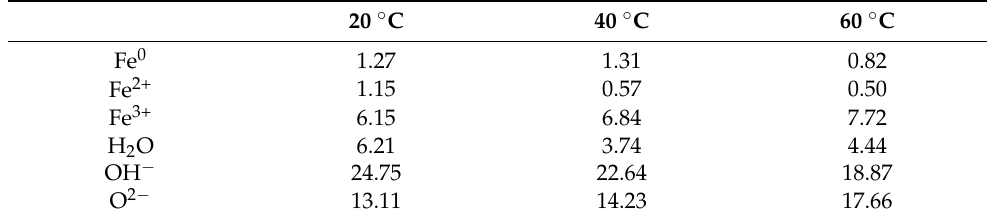
Table 2. Peak area